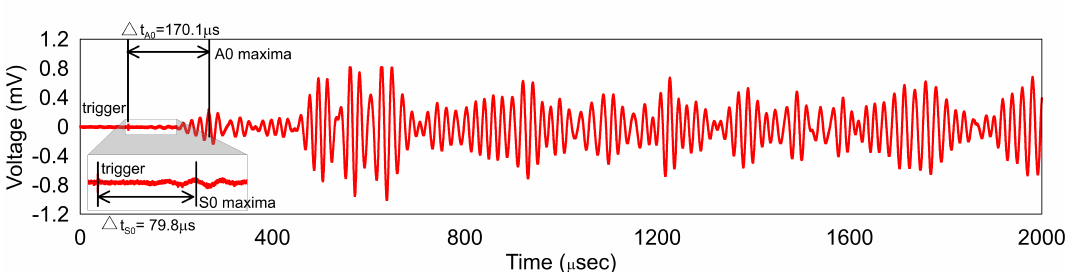
Figure 8. Time of arrival (TOA) for 50 kHz S 0 and A 0 waves excited at